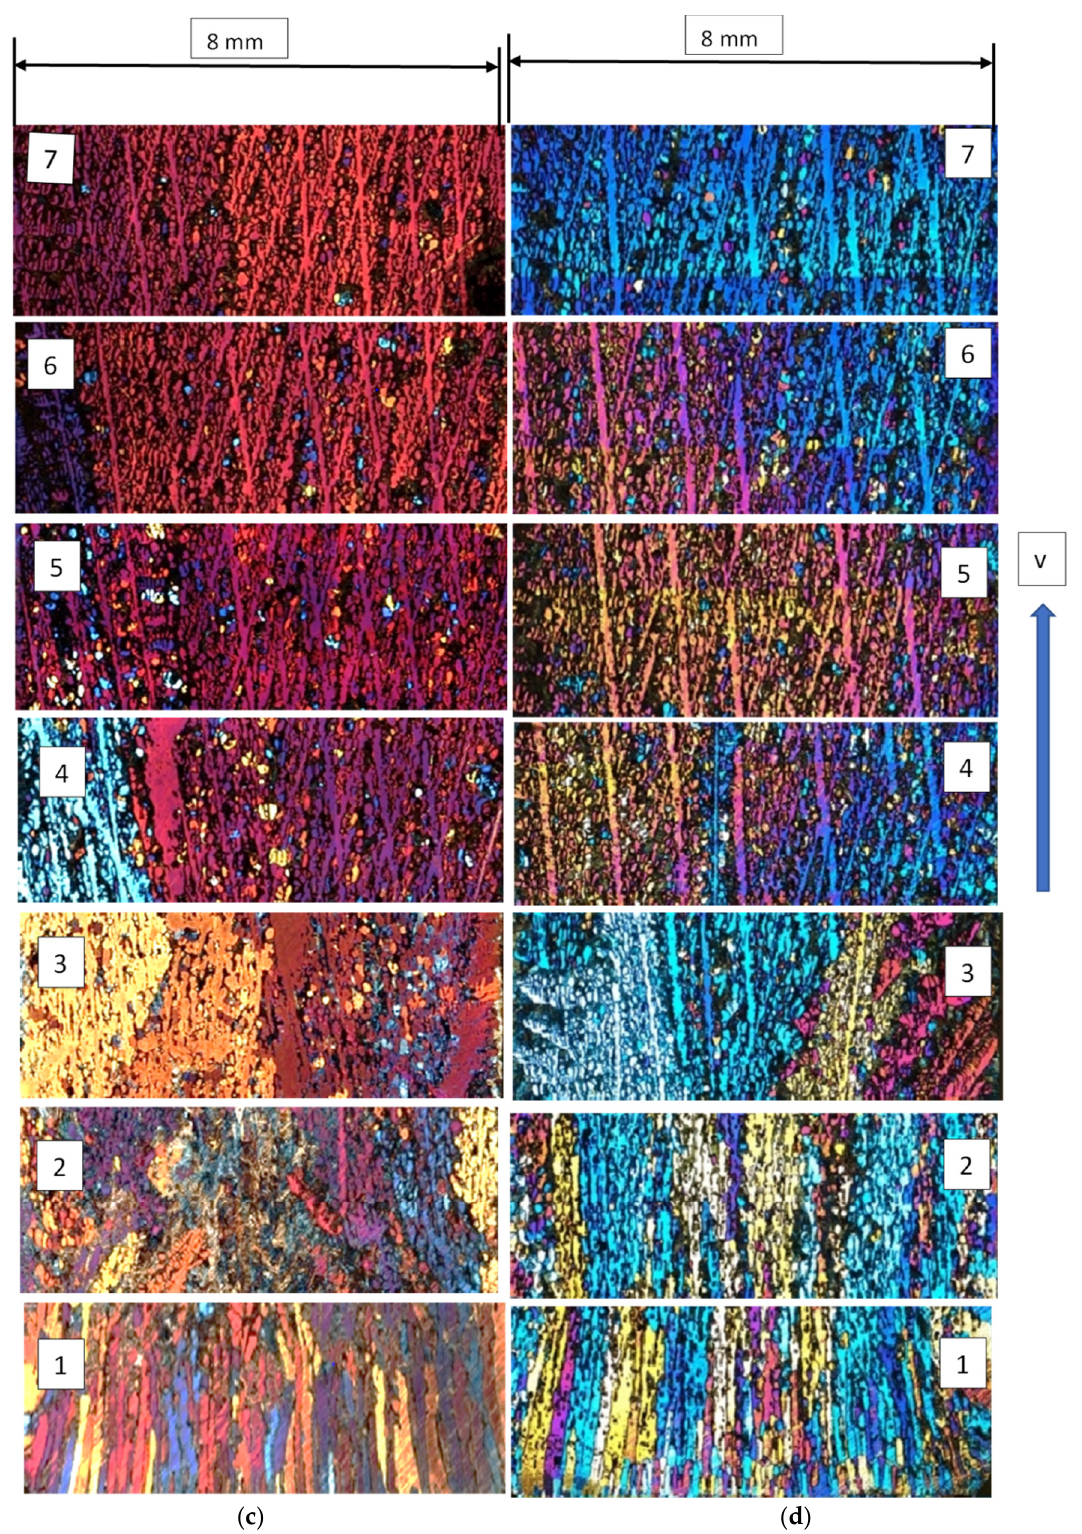
Figure 8. ( a ) Longitudinal section of Sample GB1 at cross section 1 to 7. The blue arrow shows the direction of solidification. ( b ) Longitudinal section of Sample GB2 at cross section 1 to 7. The blue arrow shows the direction of solidification. ( c ) Longitudinal section of Sample GB5 at cross section from 1 to 7. The blue arrow shows the direction of solidification. ( d ) Longitudinal section of Sample GB6 at cross section from 1 to 7. The blue arrow shows the direction of solidification.